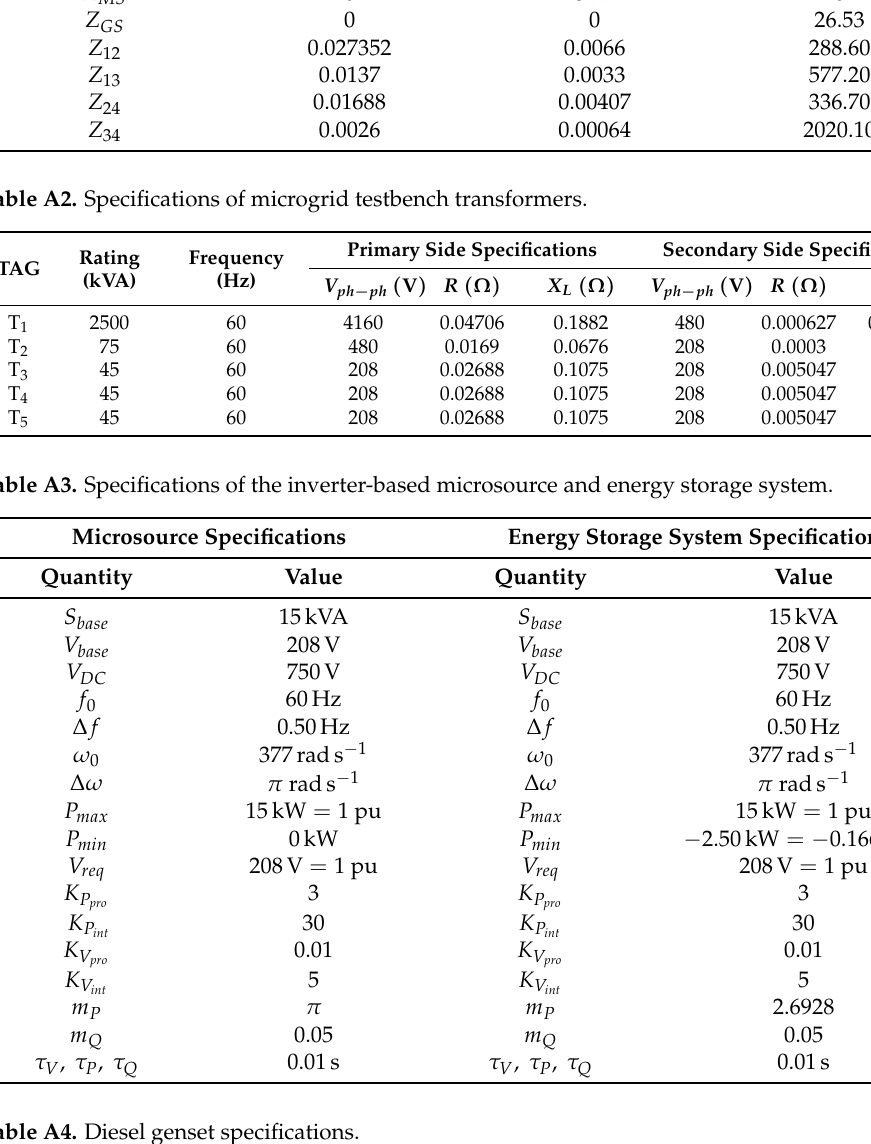
Table A4. Diesel genset